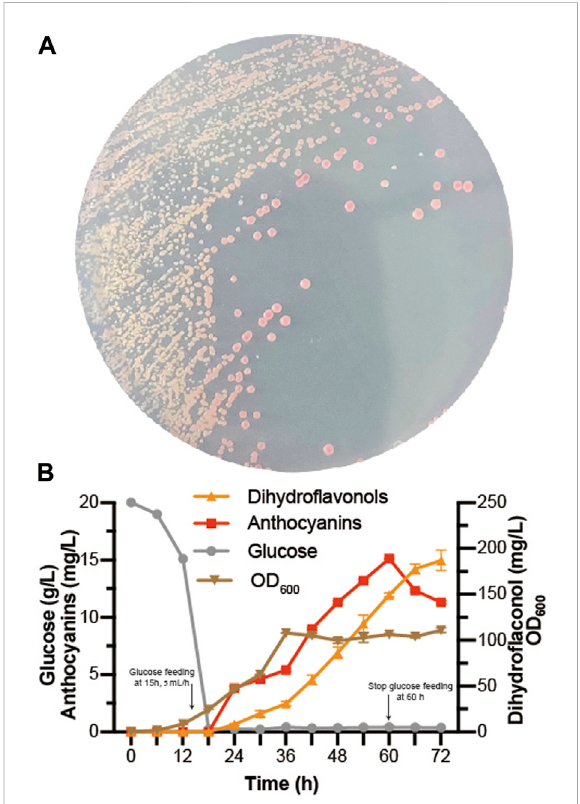
FIGURE 6 De novo biosynthesis of anthocyanins (A) BA-32 strain was grown for 4 days in the SC medium plate (B) Dihydro fl avonols, including dihydrokaempferol, dihydroquercetin, and dihydromyricetin; anthocyanins, including pelargonidin-3- O -glucoside, cyanidin-3- O -glucoside, delphinidin-3- O -glucoside, pelargonidin, cyaniding, and delphinidin. The fed- batch fermentation was performed with a 5-L bioreactor containing 2.5 L of YPD. The dissolved oxygen was maintained at 10% (degree of saturation) with the agitation ranging from 250 to 600 rpm. The glucose was fed after 15 h at the rate of 5 ml/h and stopped at 60 h. After 24 h, 0.05 mmol/L α -ketoglutaric acid, 0.5 mmol/L ascorbic acid, and 0.5 mmol/L FeSO 4 were added individually to the